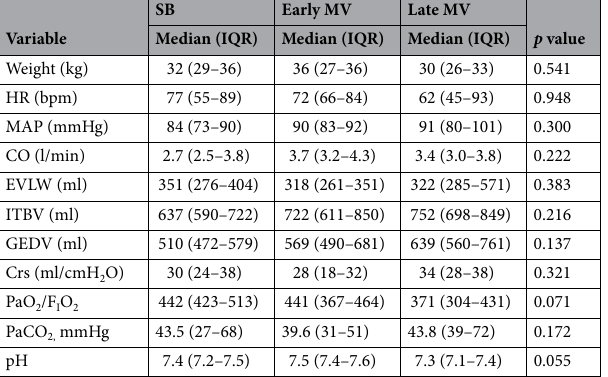
Table 1. Baseline physiologic data for the experimental groups. MV: mechanical ventilation, SB: spontaneous breathing, HR: heart rate, MAP: mean arterial pressure, CO: cardiac output, EVLW: extravascular lung water, ITBV: intrathoracic blood volume, GEDV: global end diastolic volume, Crs: respiratory system compliance.